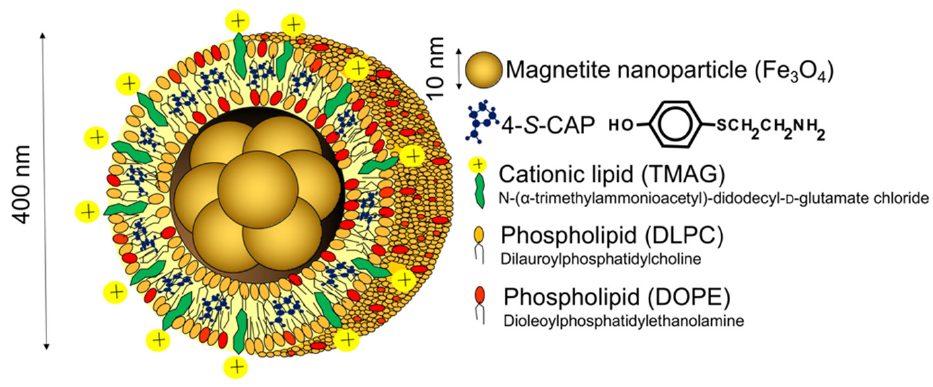
Figure 3. Illustration of 4- S -cysteaminylphenol (4- S -CAP)/magnetite cationic liposome (MCL).